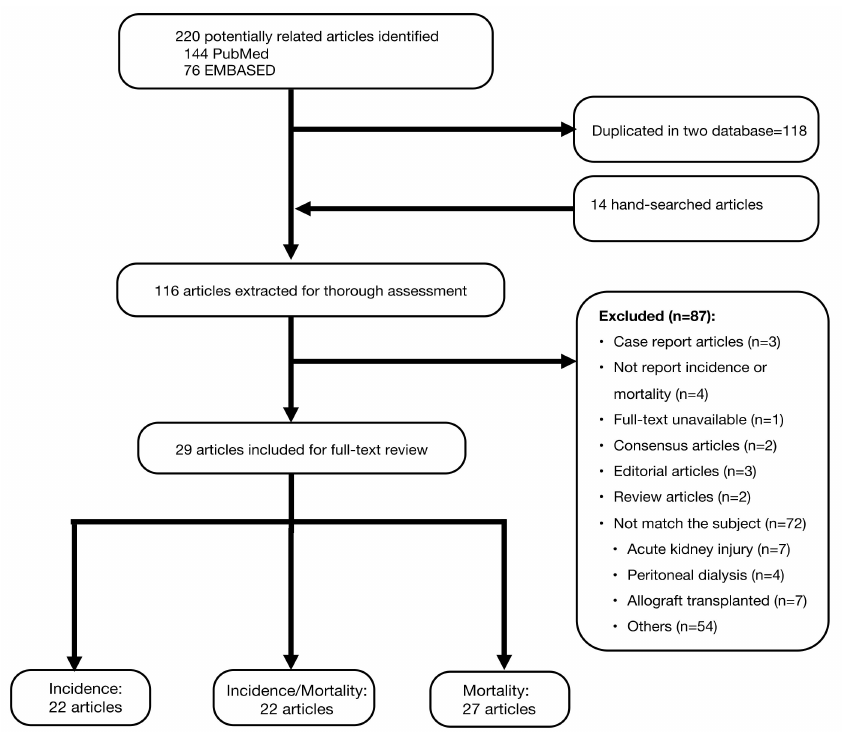
Figure 1. Flow chart of literature search and